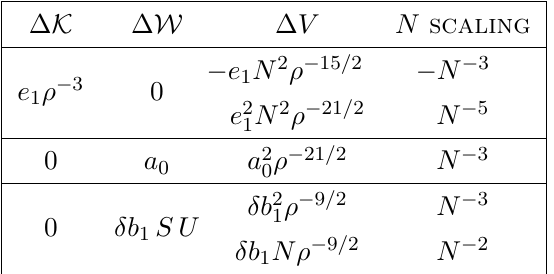
Table 6 . Contribution of the various terms to the scalar potential. Only one of the (cid:13)ux perturba- tions ( (cid:14)b 1 ) has been listed here for ease of representation. The e(cid:11)ect of turning on perturbation to the other (cid:13)uxes in